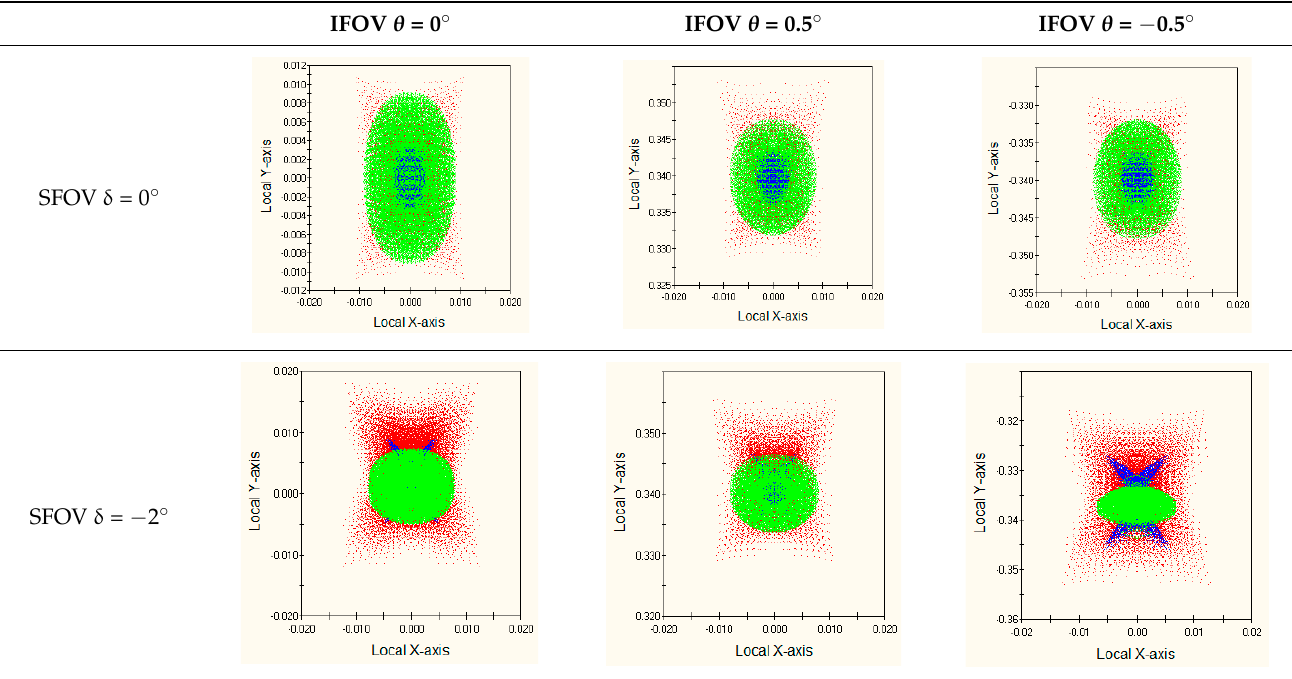
Table 6. Imaging for different SFOV and IFOV values in different bands.